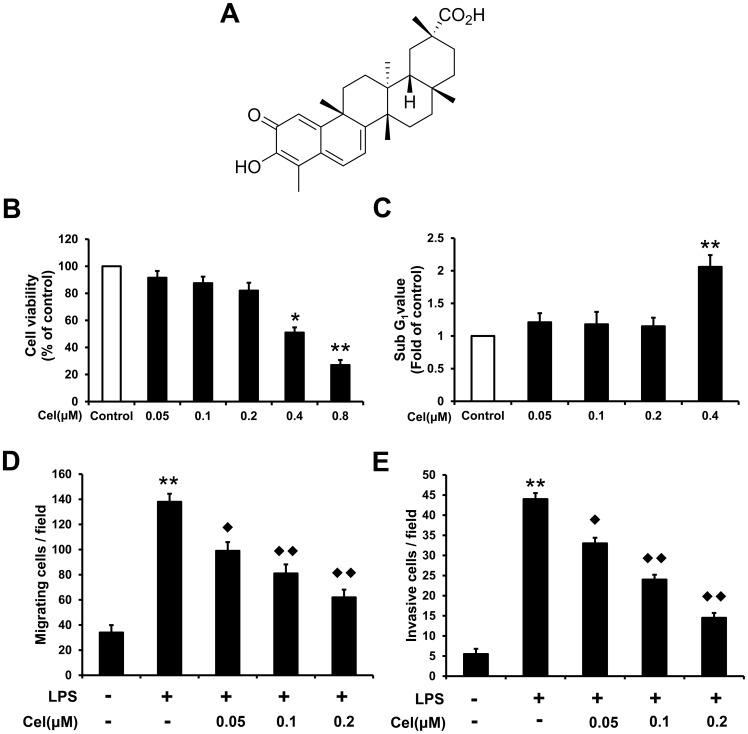
Effect of celastrol on LPS-induced RA-FLS migration and invasion.
A: Chemical structure of celastrol. B: FLSs were incubated with the indicated concentrations of celastrol in serum containing medium for 24 h, and cell viability was measured by MTT assay. *
P<0.05, **
P<0.01 versus normal control group. C: FLSs were incubated with the indicated concentrations of celastrol for 24 h. Cells were harvested and the cell cycle distribution in the sub-G1 phase was determined by FCM analysis. **
P<0.01 versus normal control group. D and E: The migration and invasion abilities of FLSs were detected by cell migration and invasion assay. FLSs were pretreated with the indicated concentrations of celastrol for 24 h. Then, FLSs were allowed to migrate with or without LPS (1 µg/mL) for 24 h. The number of migrating and invasive cells in each chamber was plotted as the mean ± SD in three independent experiments. The results were analyzed by ANOVA. **
P<0.01 versus normal control group, ⧫
P<0.05, ⧫⧫
P<0.01 versus LPS alone-treated group.